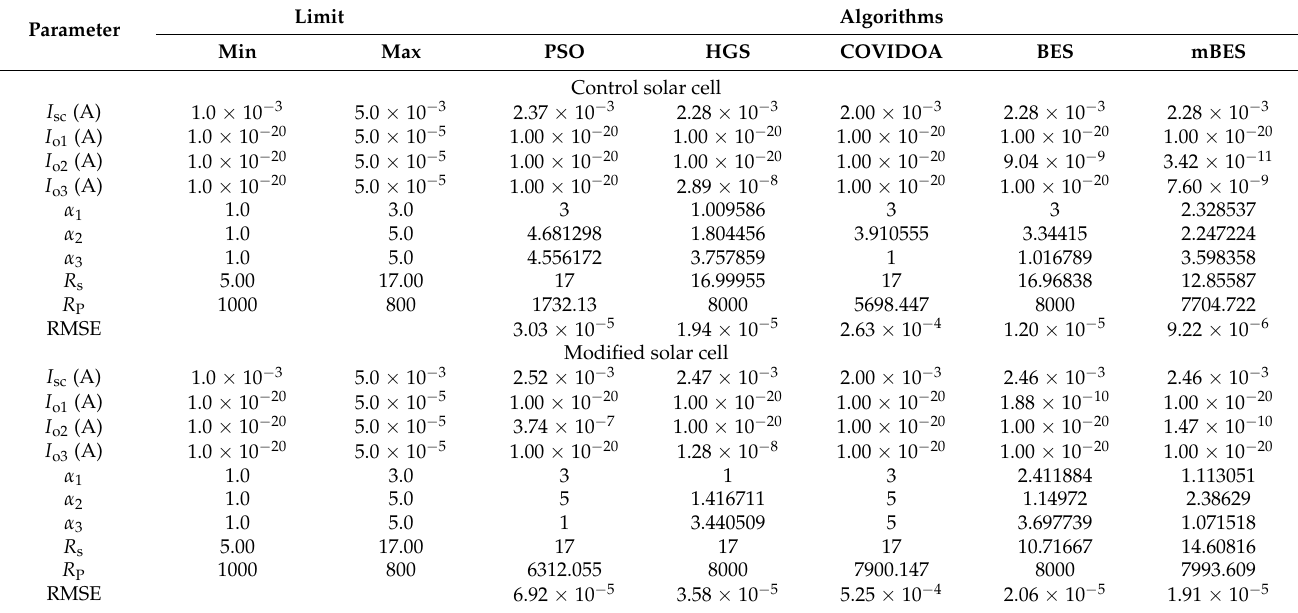
algorithm, followed by (6.14 × 10 − 5 ) obtained via HGS optimization algorithm. The minimum cost function of 9.22 × 10 − 6 was achieved by the proposed mBES optimizer tracked by BES and HGS optimizers correspondingly. Concerning the modified devices, the mean RMSE values change between 4.74 × 10 − 5 and 9.84 × 10 − 5 . The minimum mean RMSE of 4.74 × 10 − 5 was attained by the proposed mBES algorithm, followed by 8.70 × 10 − 5 using the HGS algorithm. The minimum cost function of 1.91 × 10 − 5 was achieved by the proposed mBES optimizer tailed by the BES and HGS optimizers correspondingly. Table 2. Best parameter values of PSCs using different algorithms.